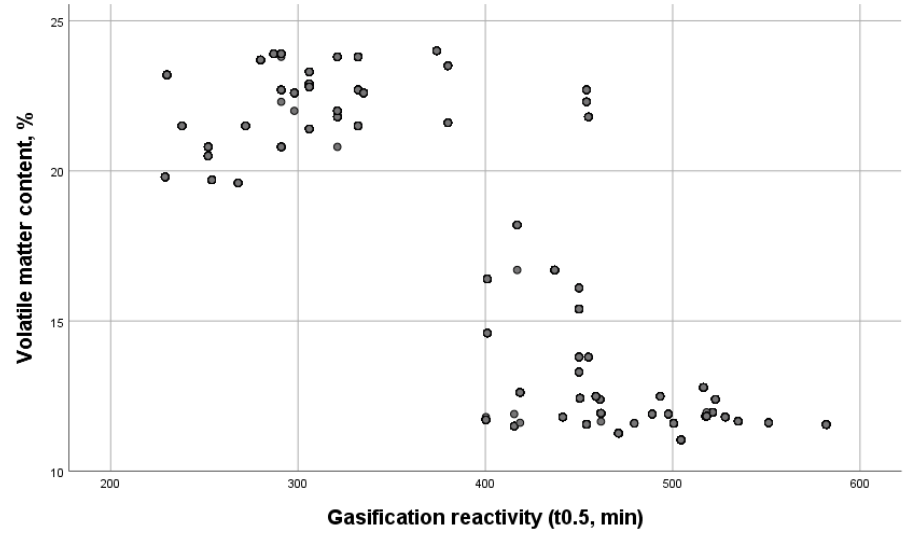
Figure 10. Scatter plot of the DTF burnouts of the injection coals versus their char gasification reac- tivities.